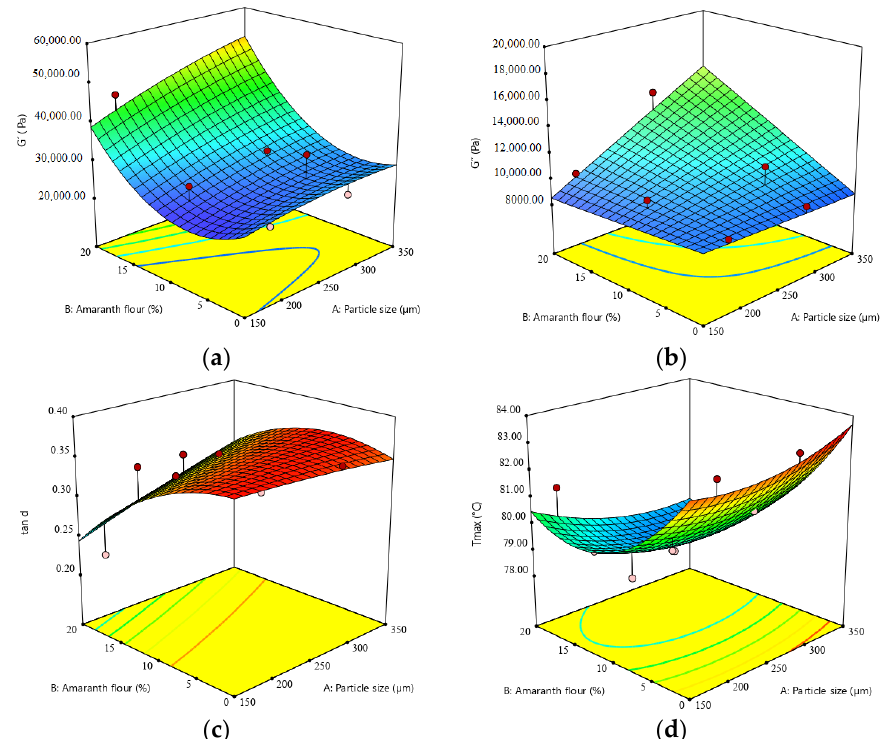
Figure 5. Three-dimensional response surface plots showing the interaction between amaranth flour particle size and addition level on: ( a ) elastic modulus (G’); ( b ) viscous modulus (G”); ( c ) loss tan- particle size and addition level on: ( a ) elastic modulus (G (cid:48) ); ( b ) viscous modulus (G (cid:48)(cid:48) ); ( c ) loss tangent gent (tan δ ); and ( d ) maximum gelatinization temperature (T max ). (tan δ ); and ( d ) maximum gelatinization temperature (T max